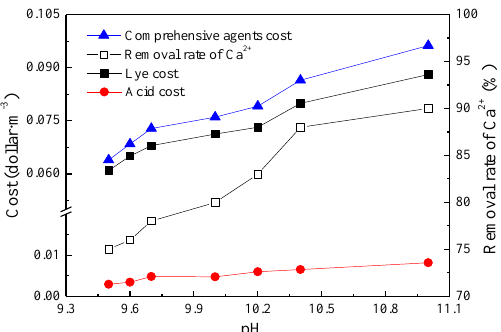
Figure 3. Hardness and Ca 2+ ion removal performance of circulating pellet fluidized beds (CFPBs).